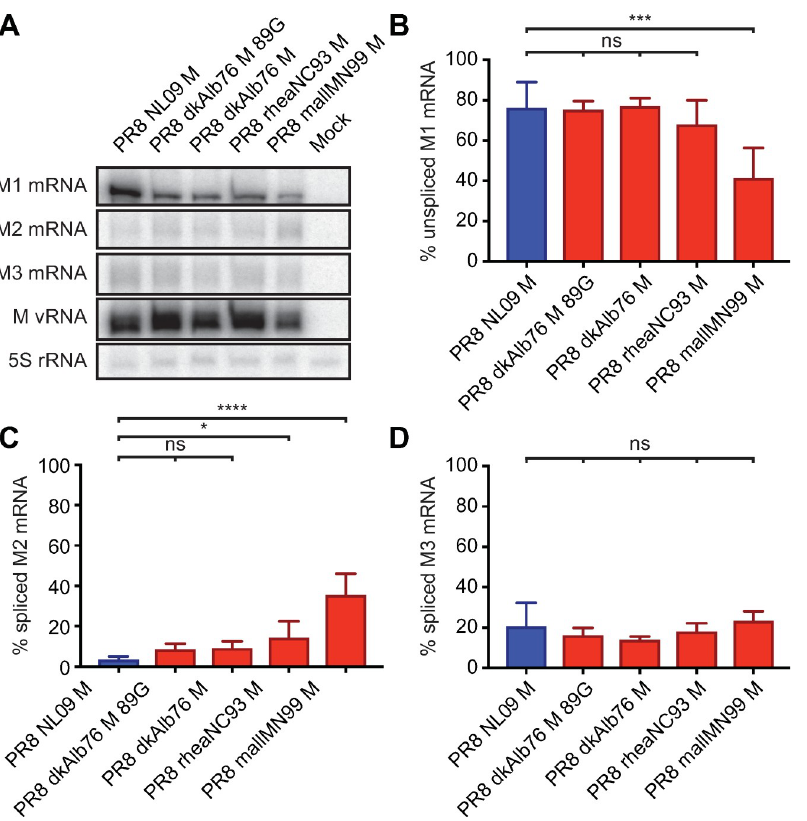
Fig 6. Ratio of mRNA 7 (encoding M1) to mRNA 10 (encoding M2) expression is high in DF-1 cells irrespective of viral M Segment host origin. DF-1 cells were inoculated at a MOI of 5 PFU/cell with PR8 viruses encoding avian or human-derived M segments and incubated at 37˚C for 8 h prior to RNA extraction. RT primer extension radiogram of virus-infected DF-1 cells: (A) 5S rRNA levels were measured to allow normalization of viral RNA. Segment 7 vRNA expression was measured to assess viral replication. Levels of mRNA 7 , mRNA 10 , and mRNA 11 mRNA expression were assessed using radiolabeled probes. (B) mRNA 7 , (C) mRNA 10 , and (D) mRNA 11 was quantitated and displayed as a percentage of total M gene-expressed mRNA. Graphs in B-D show the means with SD from three independent experiments. For each experiment, two replicate radiograms were quantitated. Statistical significance was assessed using ordinary one-way